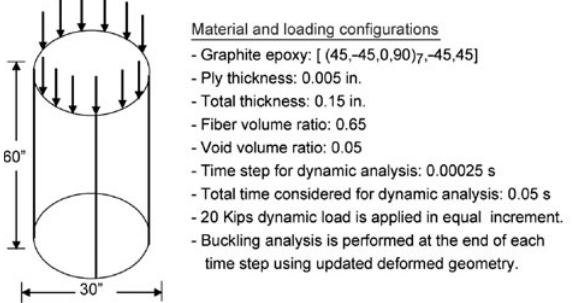
Figure 1 Buckling of a clamped-clamped composite shell subject to dynamic compressive axial loading. (1 in. = 2.54 cm; 1 kip = 4.45